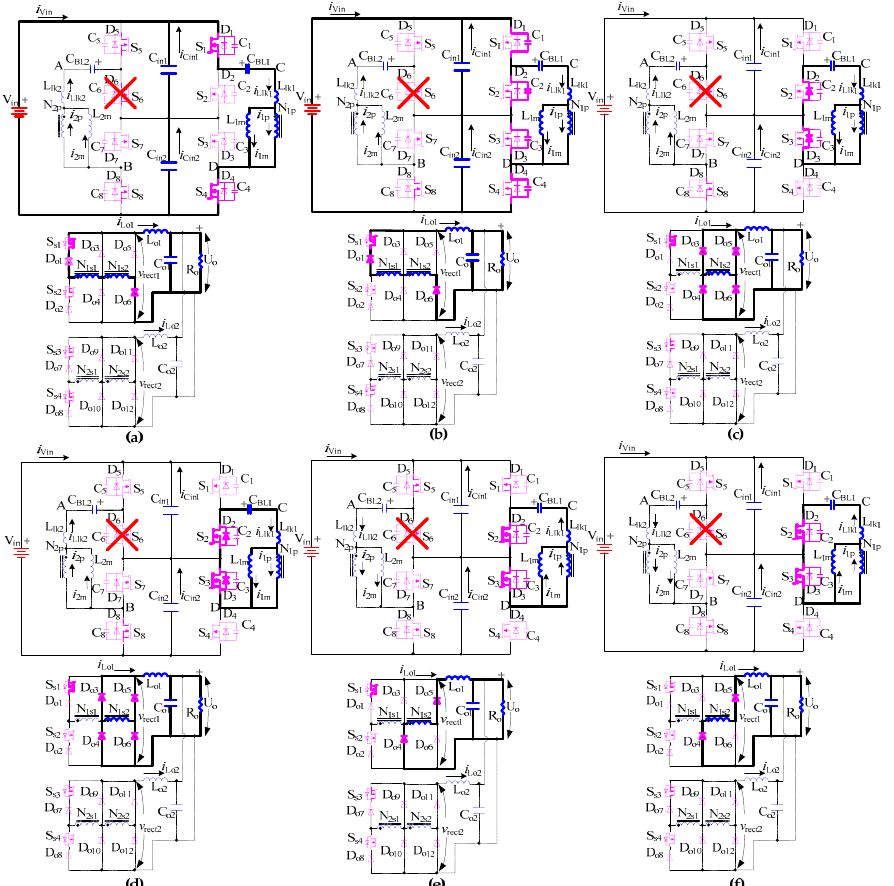
Figure 7. Stages of the secondary side modulation in failure mode: ( a ) stage 1; ( b ) stage 2; ( c ) stage 3; ( d ) stage 4; ( e ) stage 5; ( f ) stage 6.